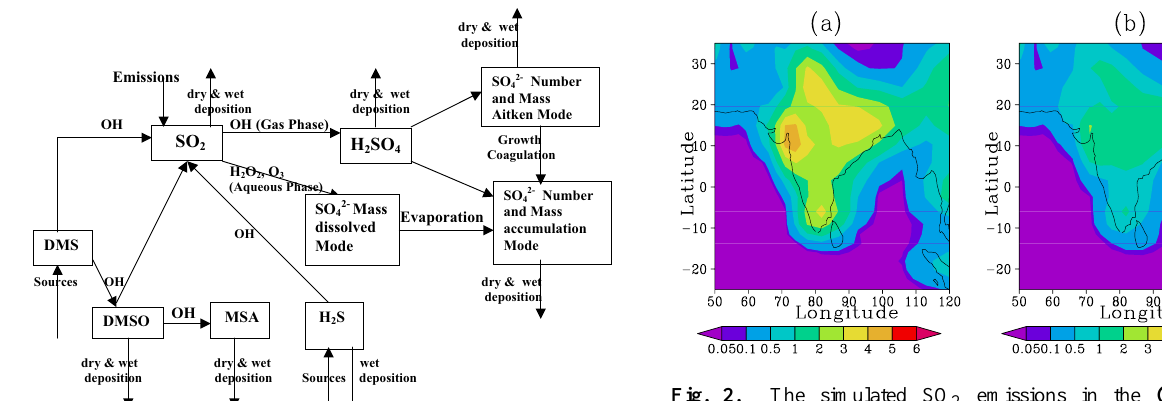
Fig. 2. The simulated SO 2 emissions in the (a) RV and (b) GEIA inventories averaged for the INDOEX-IFP period (10 5 mgSm − 2 s − 1